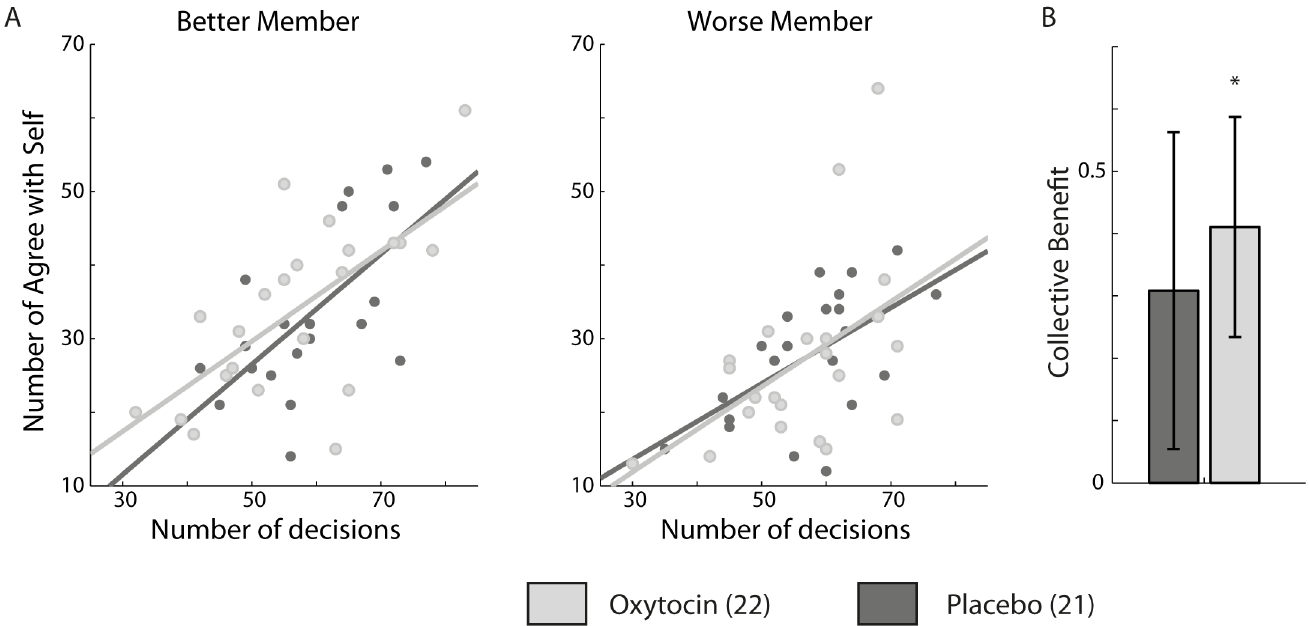
Fig 3. Oxytocin effect on egocentric bias collective benefit. (A) When announcing the joint decision participants could keep their original choice or go with the other member ’ s decision. We used ANCOVA model to estimate the relation between total number of joint decisions made by a participant and the number of egocentric (agree with self) joint decisions. This relationship is captured by the slope and intercept estimated by the ANCOVA model: steeper slope indicates an egocentric inclination, i.e. tendency to not change one ’ s mind during disagreements. We did not find a significant treatment effect, and no difference in slopes between worse and better members. (B) We fitted psychometric curves to the data from the entire experiment duration, estimating the dyadic sensitivity and the individual sensitivities of dyad members ( s Dyad , s Max , s Min ). Collective benefit is the difference between the dyadic sensitivity and the better dyad member (Sdyad-Smax). Under oxytocin dyads ’ collective benefit was significantly higher than 0 (p = 0.026), but not under placebo (p = 0.2). However, collective benefit was not significantly different between oxytocin and